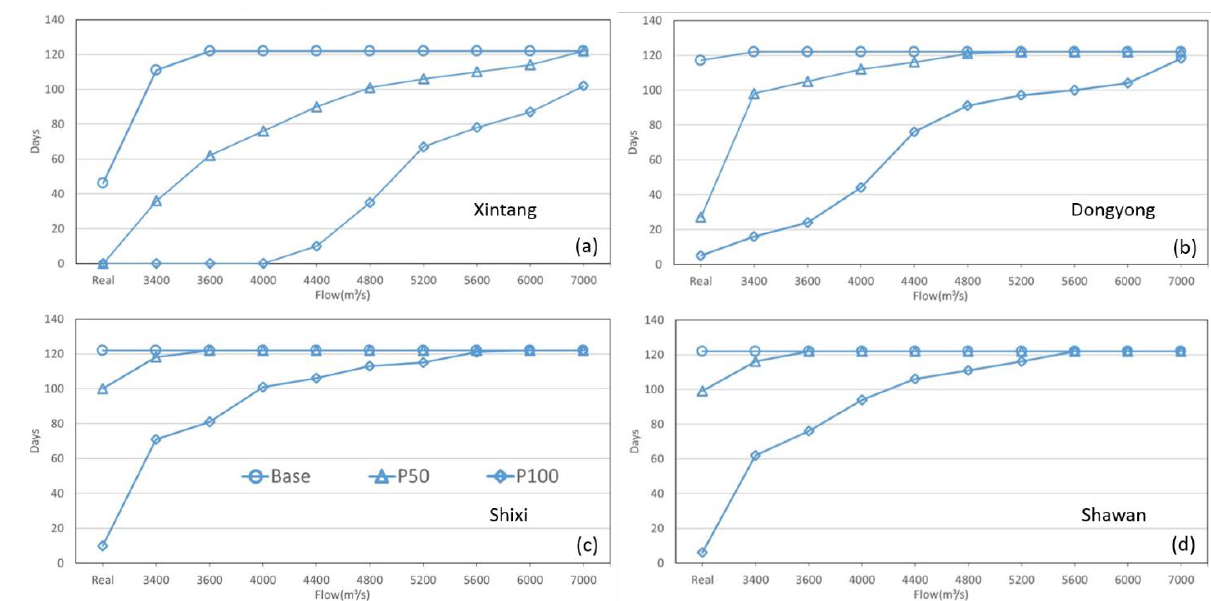
Figure 8. Number of days for which water meets the drinking-water standard (salinity < 0.45 ppt) at Xintang ( a ), Dongyong ( b ), Shixi ( c ), and Shawan ( d ), in response to flow modulation. The statistical results are based on the period 1 December 2007 to 31 March 2008 (122 days in total). The base case and each sea-level rise case are presented.